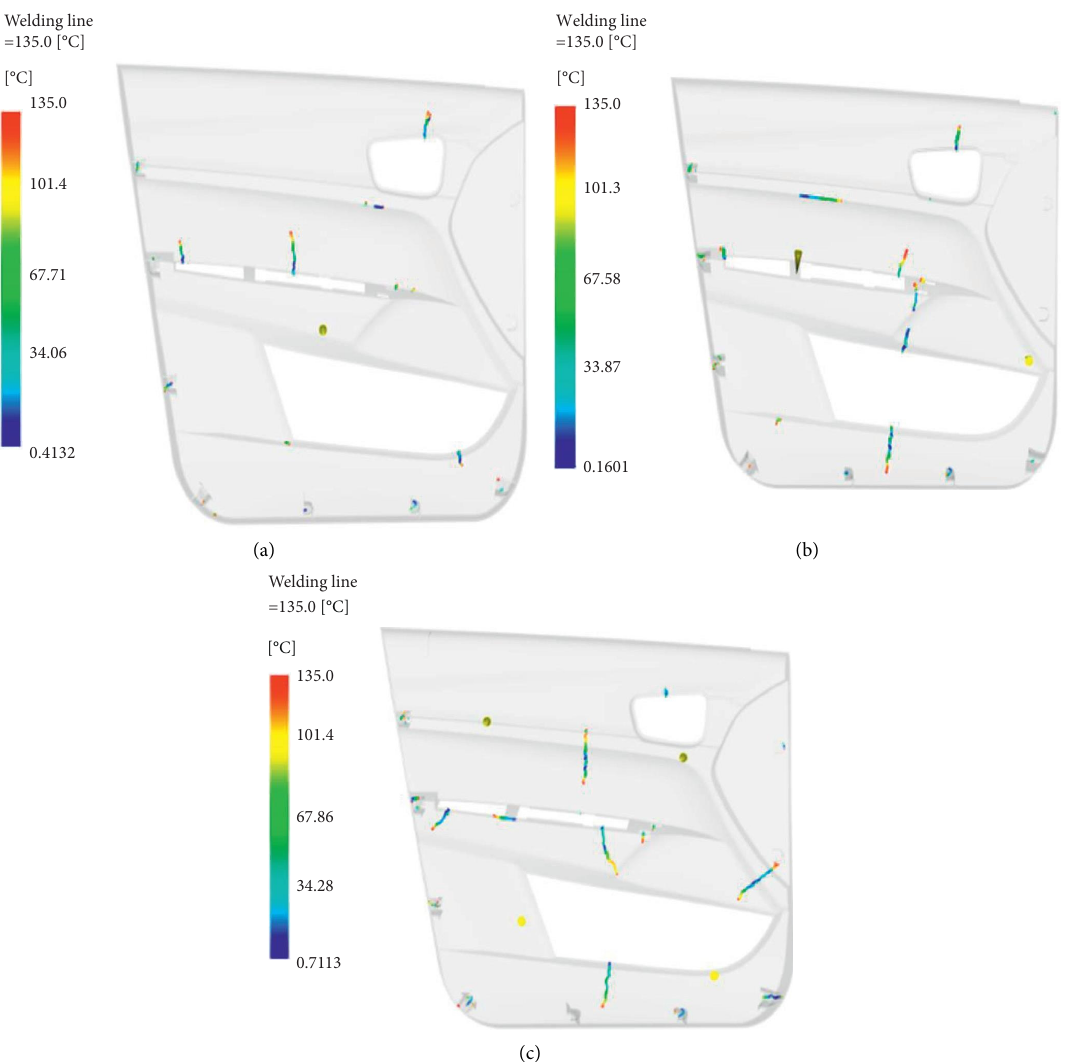
Figure 8: Welding line of three gate location schemes. (a) Single gate. (b) Two gates. (c) Four